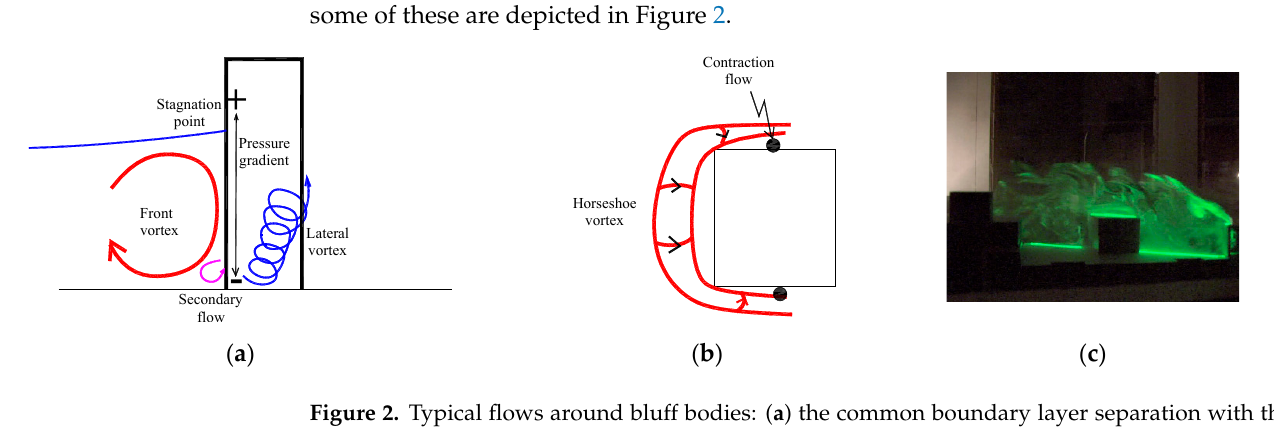
Figure 2. Typical flows around bluff bodies: ( a ) the common boundary layer separation with the production of vortices and turbulence; ( b ) the common horse-shaped vortices developed at the base of high buildings developing strong convergence/divergence of the flow producing strong vorticity gradients; ( c ) the flow complexity around multiple obstacles very closed to each other as seen by a wind tunnel experiment.